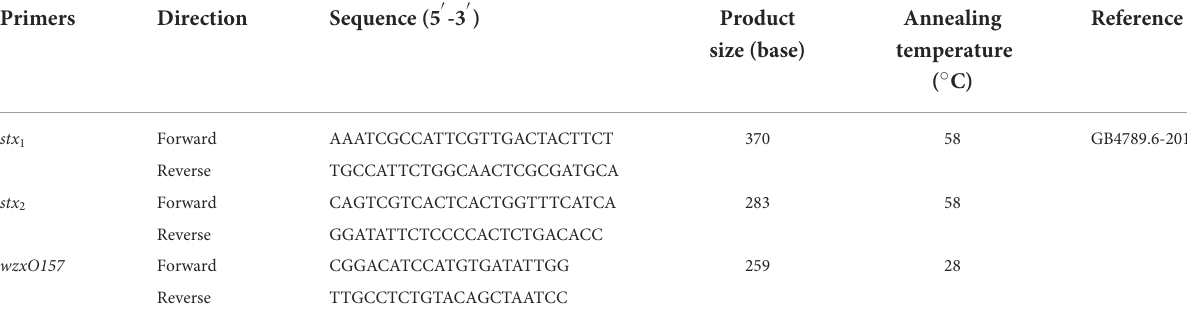
TABLE 1 Sequences of all primers and annealing temperature used in this work.